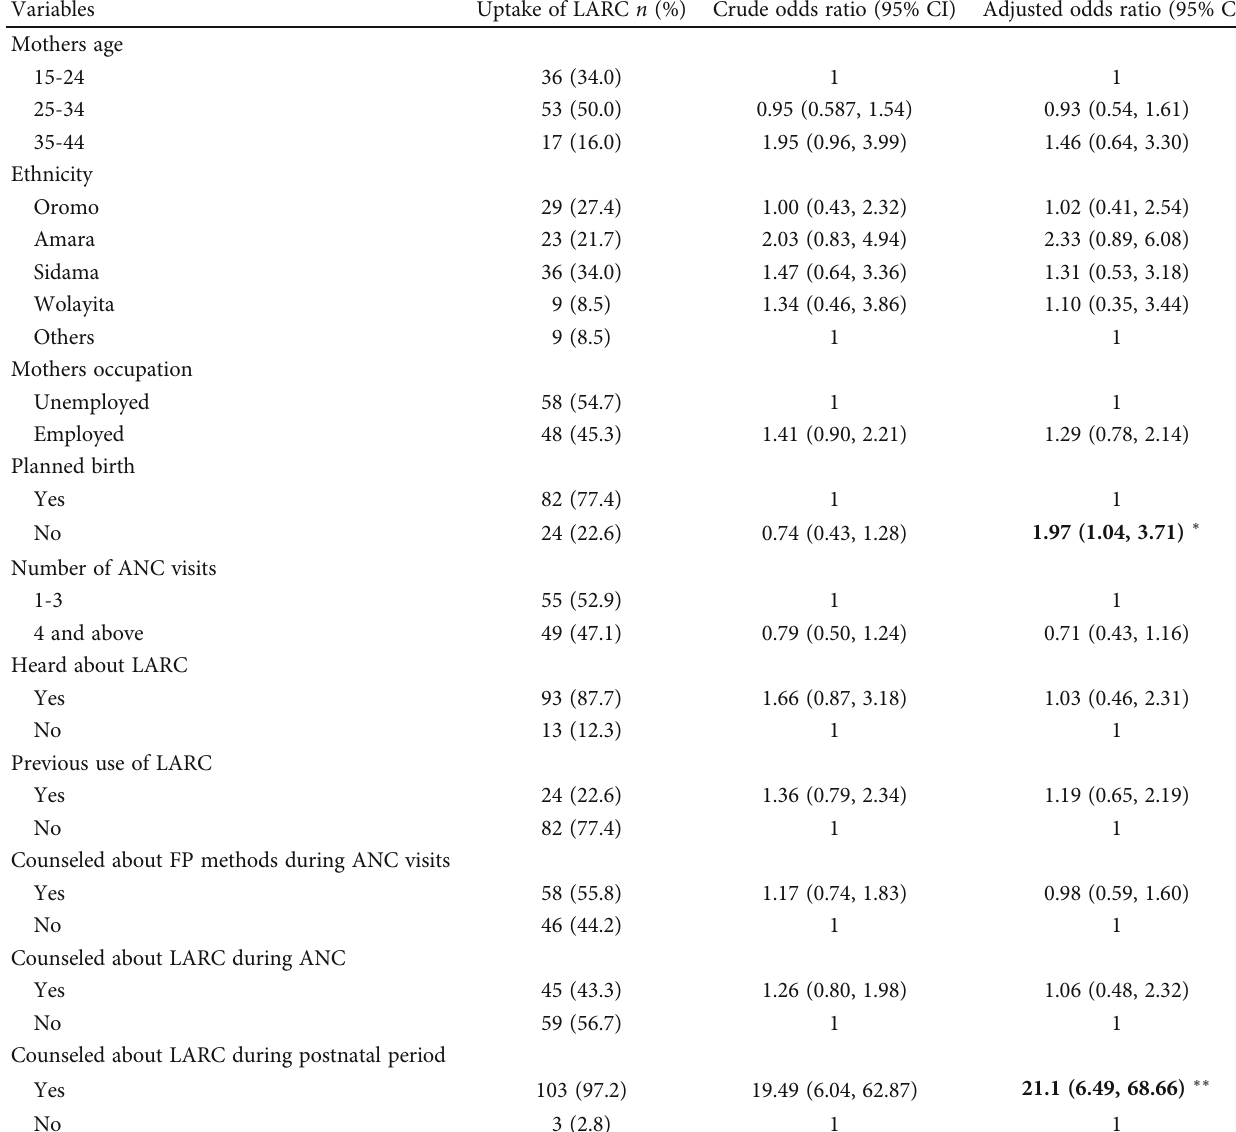
Table 4: Factors associated with uptake of postpartum LARC methods in HUCSH, Ethiopia, April